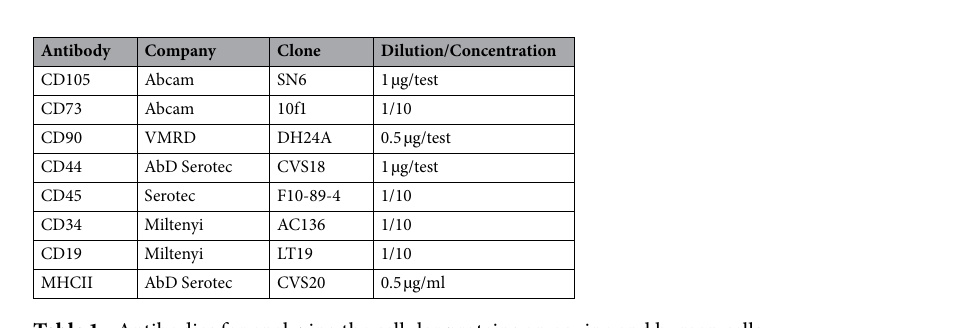
Table 1. Antibodies for analyzing the cellular proteins on equine and human